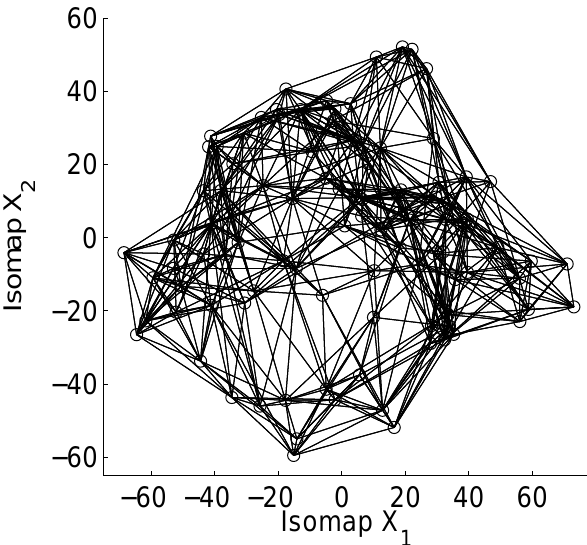
Fig. 4. Illustration showing the neighborhood graph for the first 100 anomalous SLP observations within the two-dimensional Isomap embedding space. The data have been scaled to zero-mean and unit variance. Axis units